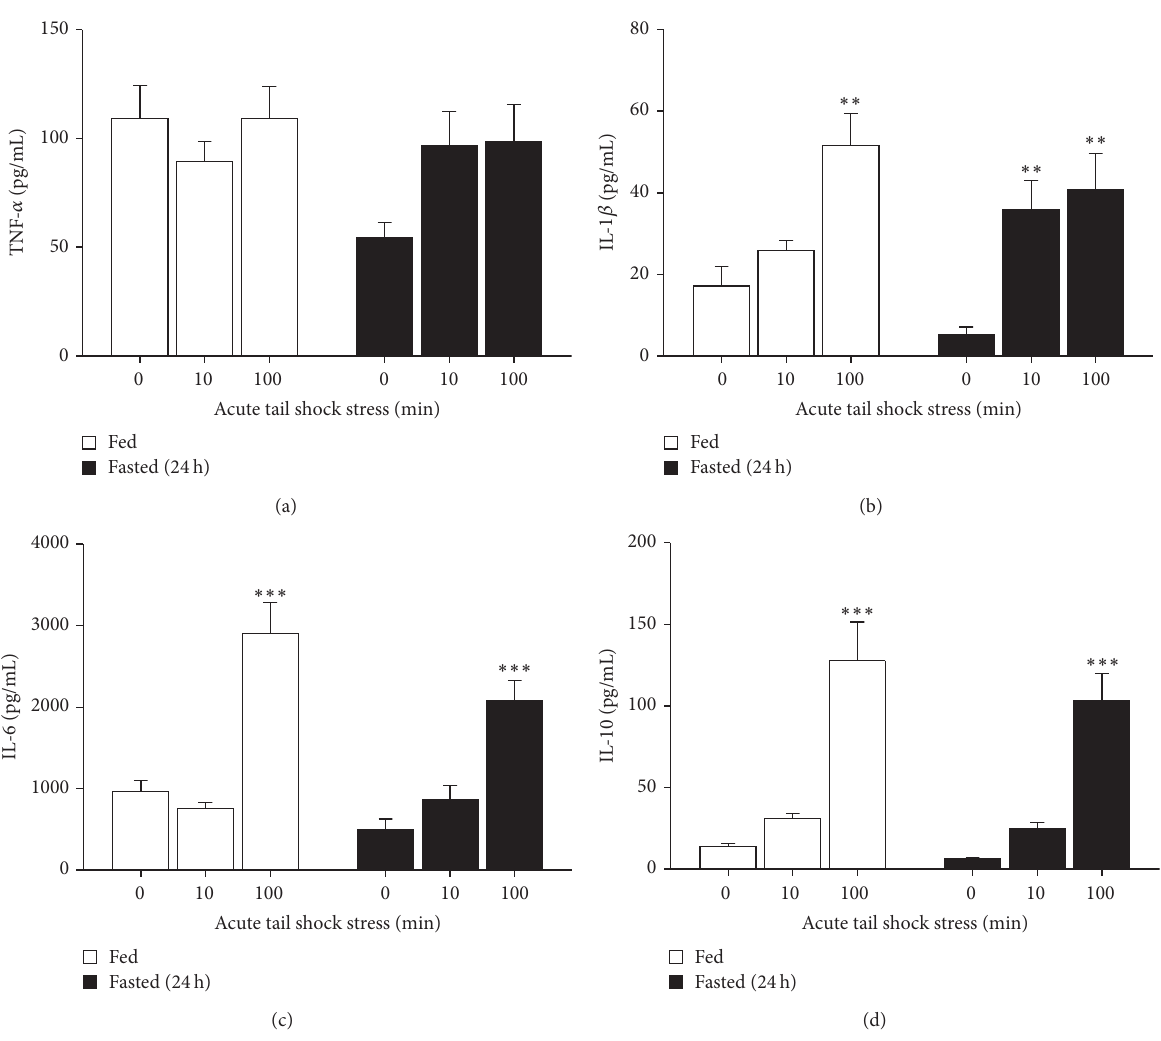
Figure 1: Effect of a 24 h fast on the TNF- 𝛼 , IL-1 𝛽 , IL-6, and IL-10 response to 10 or 100 acute inescapable tail shocks in blood plasma. Fed (FED ◻ ) or fasted (FASTED ◼ ) rats were exposed to 0 (control condition), 10, or 100 acute, inescapable tail shocks (IS) and immediately sacrificed and trunk blood was collected. Shown is the mean (+SEM) plasma concentration of (a) tumor necrosis factor alpha (TNF- 𝛼 ), (b) interleukin- (IL-) 1 beta (IL-1 𝛽 ), (c) IL-6, and (d) IL-10. ∗∗ 𝑝 < 0.001 , ∗∗∗ 𝑝 < 0.0001 (0IS versus 10 or 100IS).